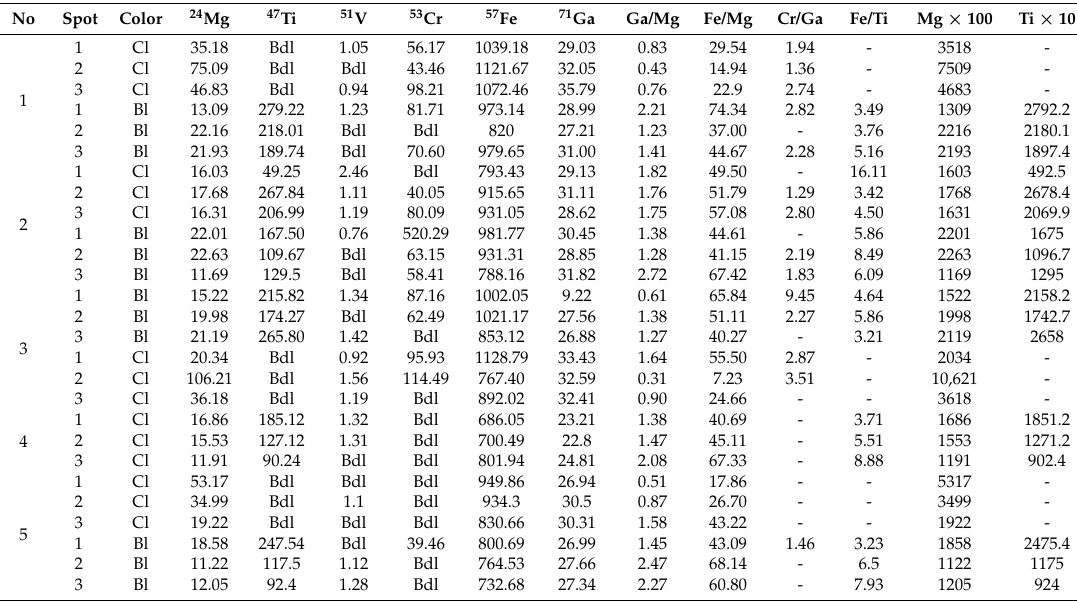
Table 1. The trace-elements composition of sapphire colored zones by LA-ICP-MS 1